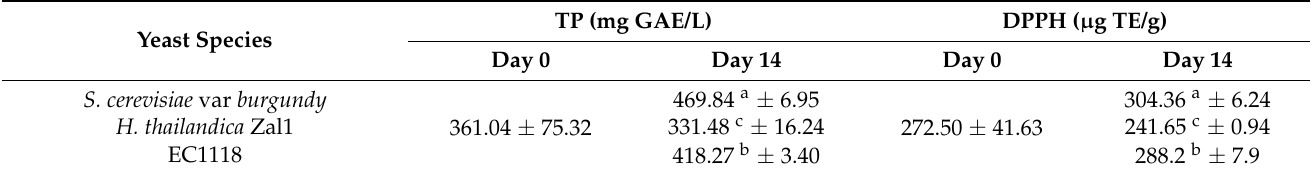
Table 1. Total phenolic (TP) compounds and antioxidant activities of plum wines fermented by different